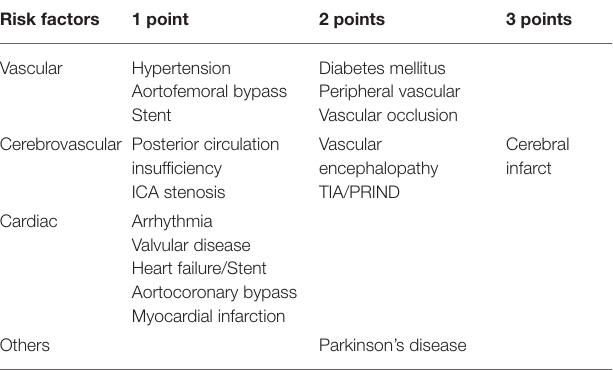
TABLE 1 | Comorbidity index introduced by Kiefer et al.